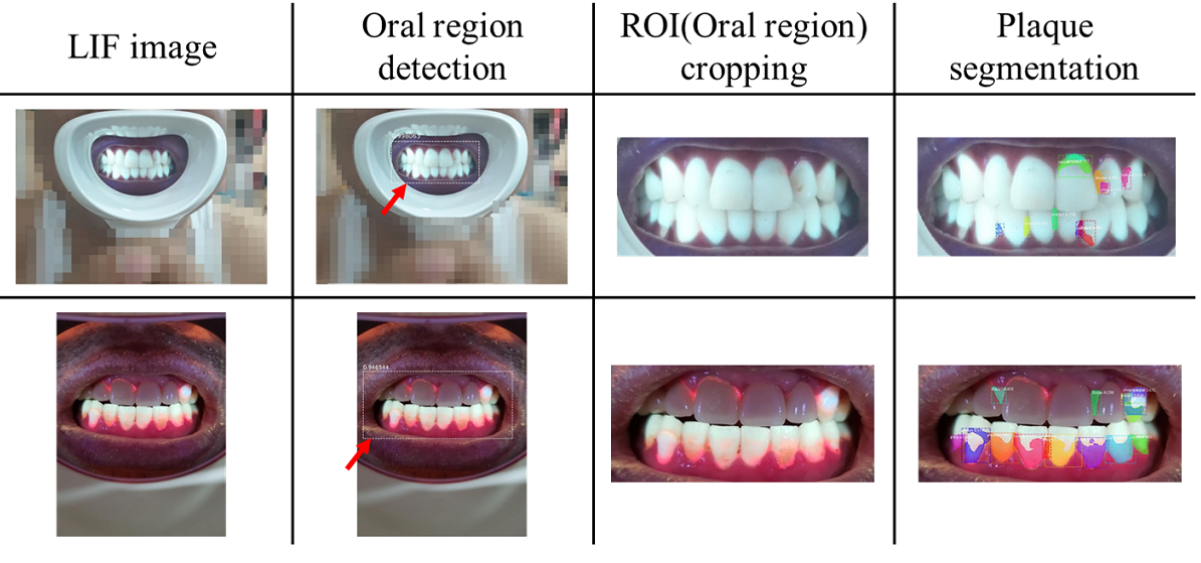
Figure 5. Representative images obtained during deep learning–based oral hygiene analysis. The red arrow points to the predicted bounding